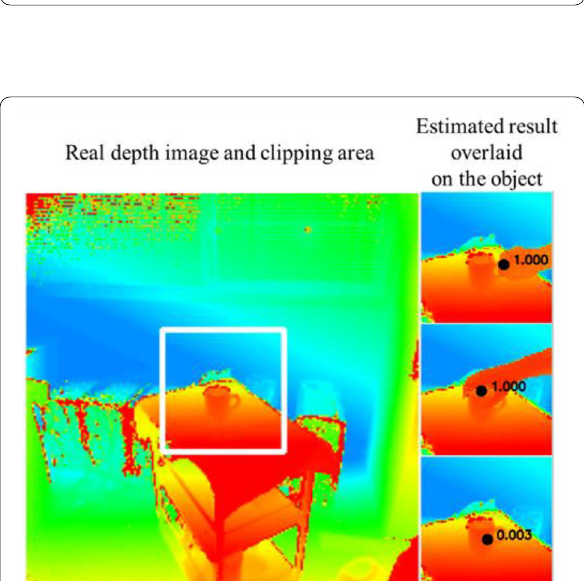
Fig. 14 The recall results of the multiple grasping methods for a real image. The region cropped by the white frame in the left image is the input object image. Each row of the right image corresponds to the recalled grasping